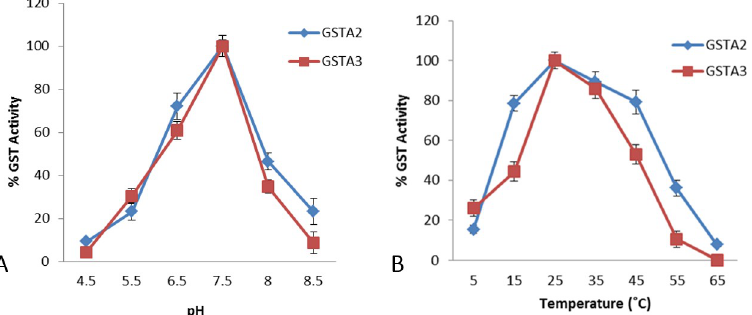
Fig 4. Optimal pH (A) and temperature (B) of rDdGSTA2 and rDdGSTA3 of D . discoideum . A standard GST assay (CDNB conjugation) indicated the optimal pH and temperature for maximal activity of rDdGSTA2 and rDdGSTA3 were 7.5 and 25˚C